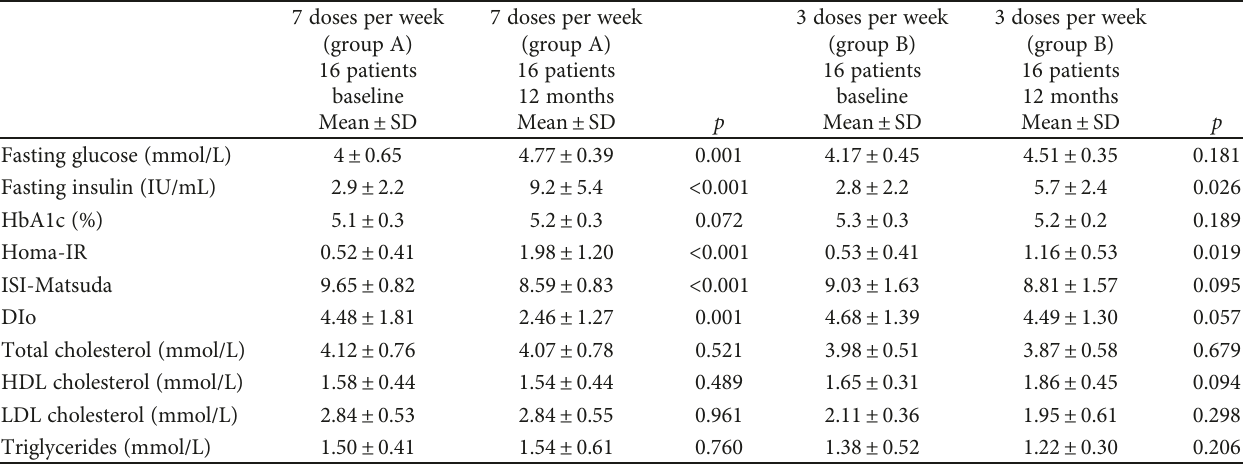
Table 3: Metabolic parameters of patients grouped according to the GH treatment regimen (group A and group B) at baseline and after 12 months of